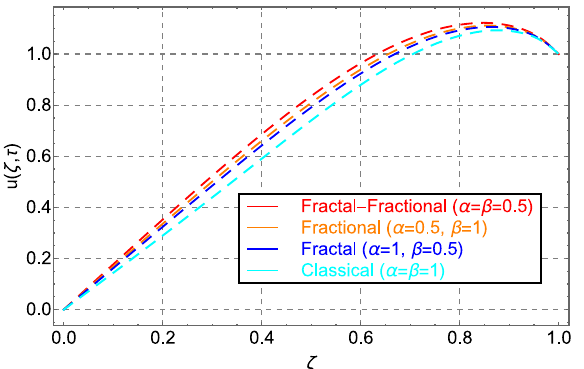
Figure 2. Comparison of velocity distribution for fractal-fractional, fractal, fractional and classical order.